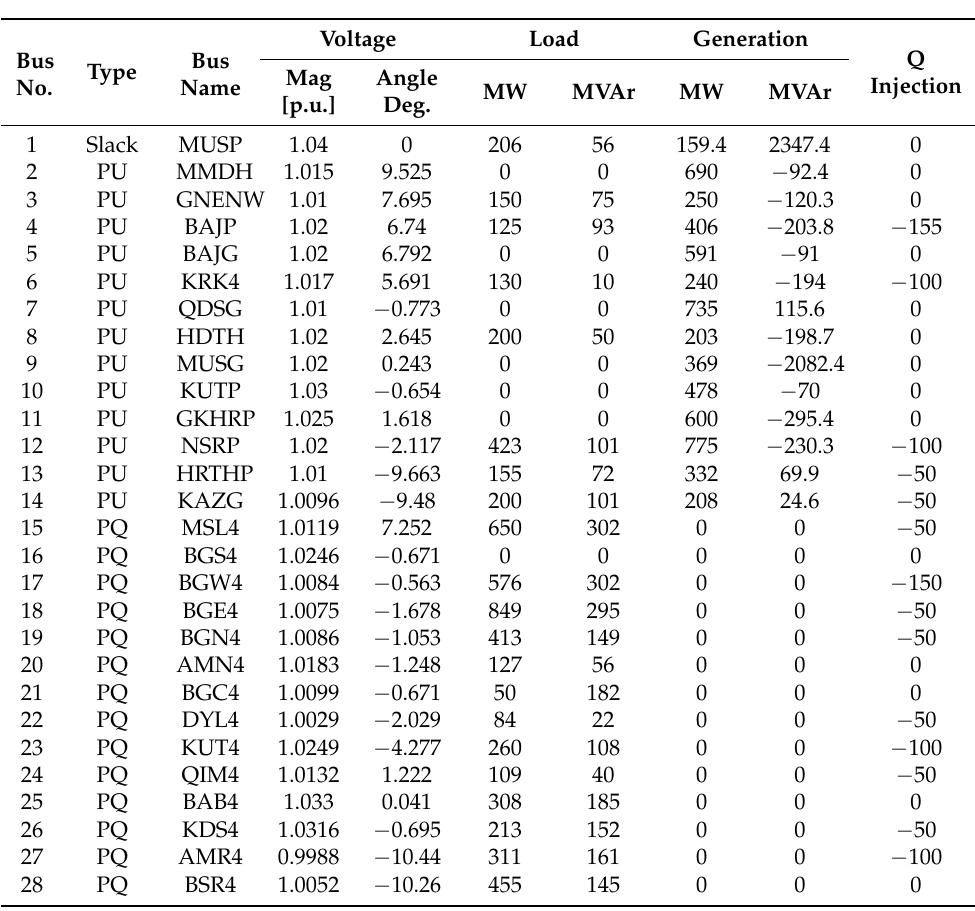
Table A4. The node’s data of ISGHV (400 kV).